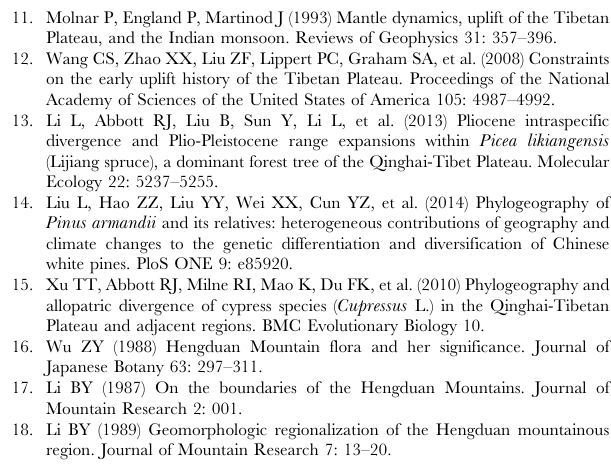
Figure S1 Correlation between the F statistics and grouping number ( K =2–10) from the SAMOVA results. (a) results based on pDNA haplotypes; (b) results based on ITS ribotypes. (TIF) Figure S2 Mismatch distribution analyses of the three multiple-haplotype pDNA clades. The histogram of observed mismatch frequencies and the best-fit curve of the sudden expansion model was shown. Table S1 Locations of populations of R. kirilowii sampled, sample sizes (n), frequencies of cpDNA haplotypes and ITS sequences per population, and estimates of haplotype diversity and nucleotide diversity for chlorotypes and ribotypes within populations. Table S2 Haplotype composition of 29 sampled popu- lations of Rhodiola kirilowii . Table S3 Ribotypes composition of 29 sampled popu- lations of Rhodiola kirilowii